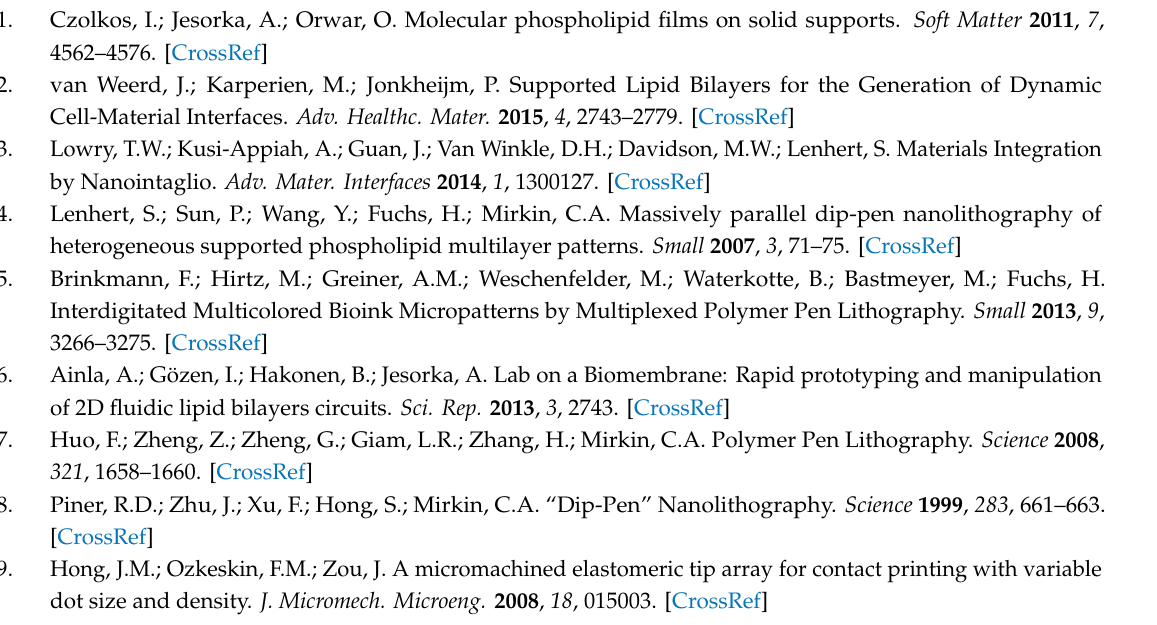
Figure S1: Representative microscope images of the polydimethylsiloxane PDMS stamp obtained by the microscope coupled to the printer setup, Figure S2: Results of the benchmarking of the environmental control system. Figure S3: Alignment challenge and o ff set correction in two-color printing, Figure S4: Results and analysis of two-color printing experiments, Figure S5: Intensity / area vs. dwell time plots without normalization, Figure S6: Comparison of six independent experiments to analyze the influence of dwell time on lipid ink transfer, Figure S7 Intensity / area vs. relative humidity plots without normalization along with recorded images, Figure S8: Plot of the average fluorescence intensities against ∆ d, Figure S9: Analysis of signal crosstalk between the di ff erent fluorescence